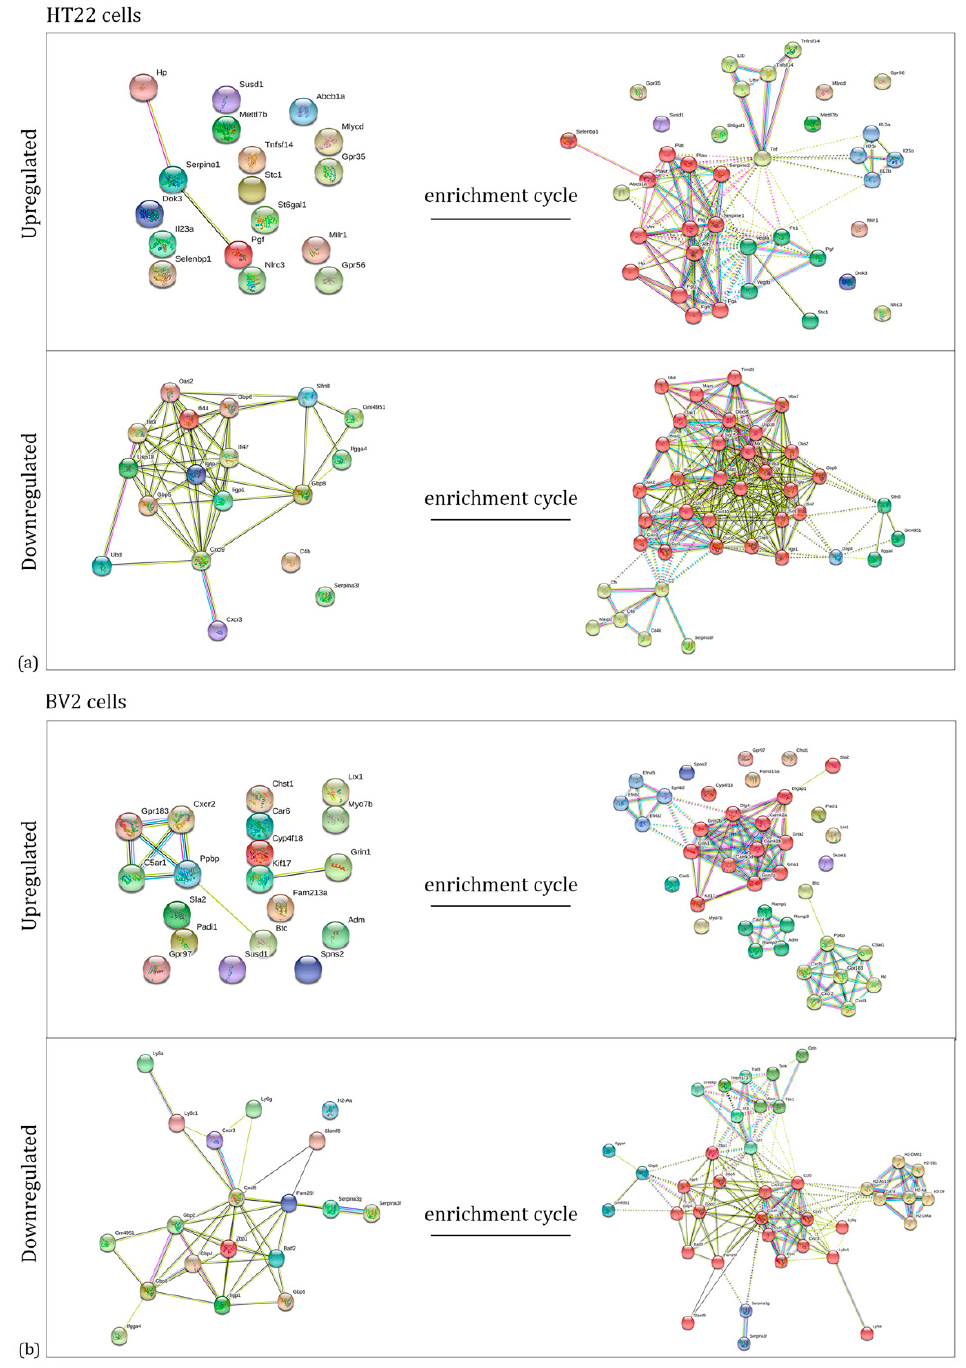
Figure 3. Networks representing the interactions among the proteins corresponding to the selected genes before (left) and after the enrichment procedure (right) in HT22 ( a ) and BV2 ( b ) cells.